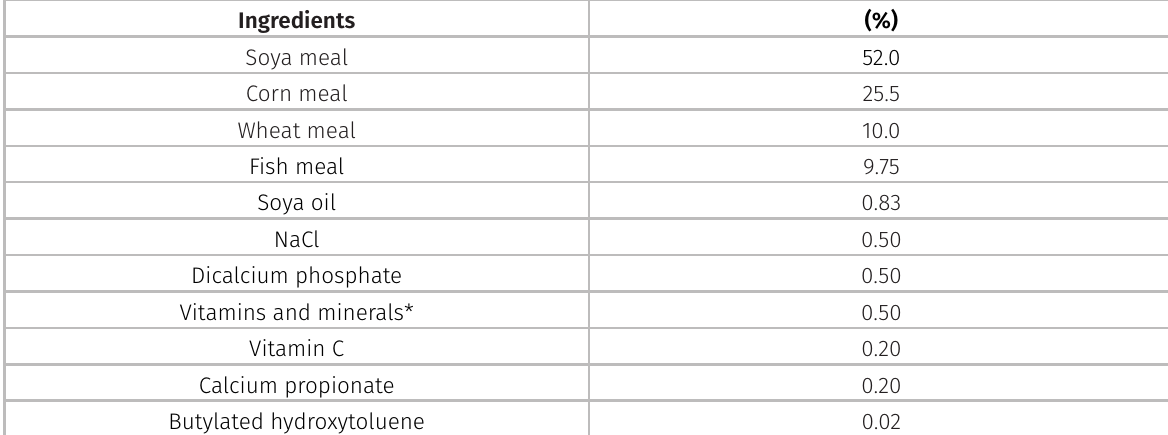
Table I. Composition of experimental diets of control group supplied to Nile